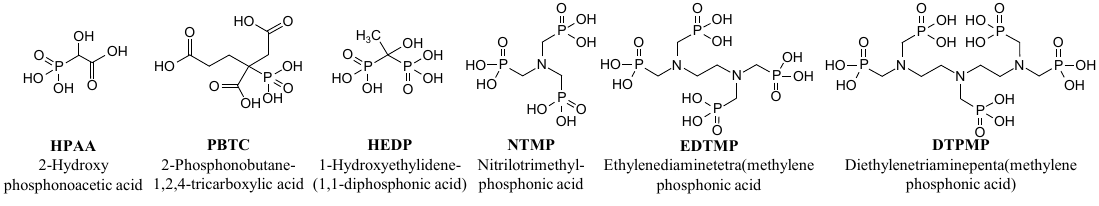
Figure 1. Chemical structures of considered phosphonates.